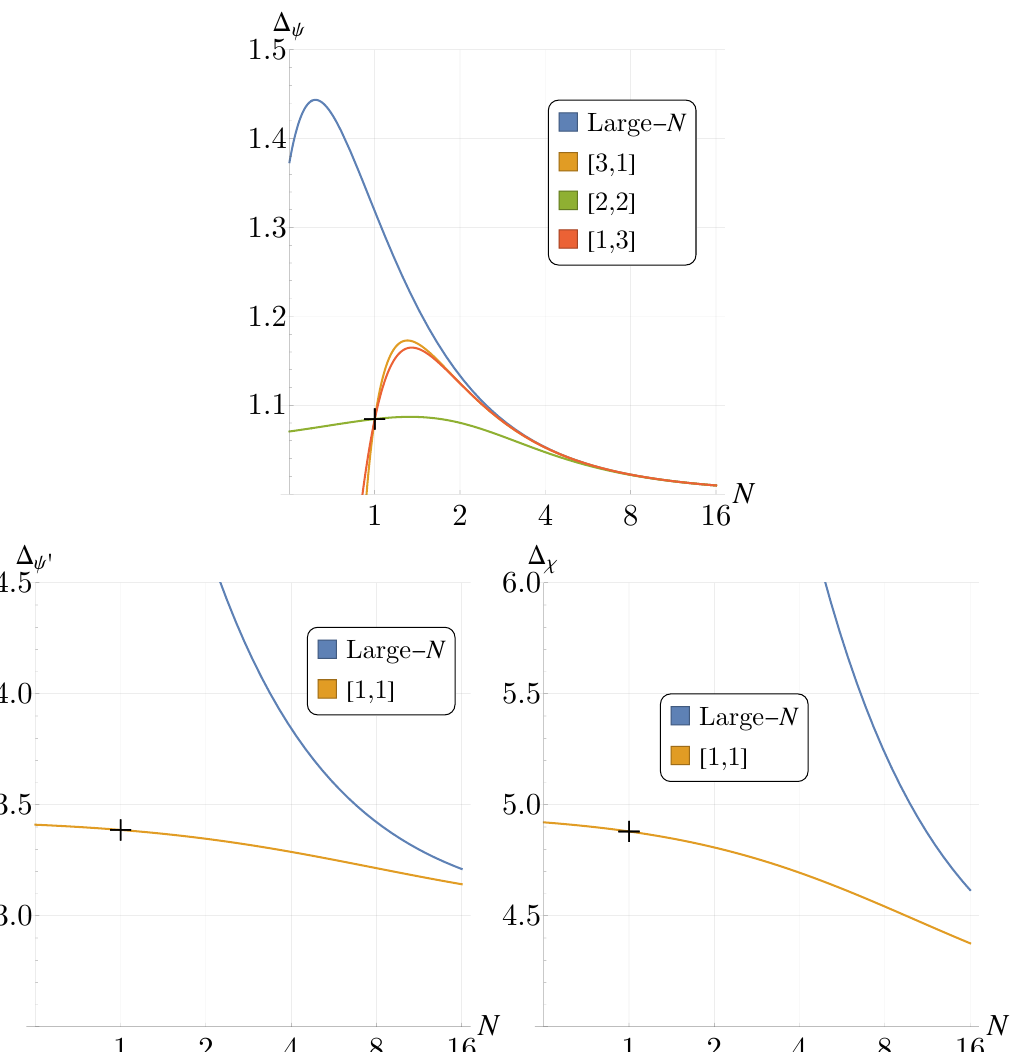
Figure 4 . Two sided-Padé approximation for the scaling dimensions of low-lying fermionic operators, in the vector representation of the O ( N ) global